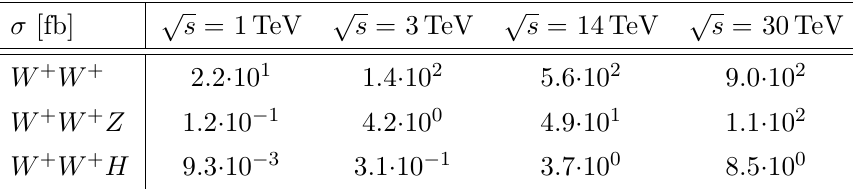
Table 5 . SM cross sections [fb] for sample W + W + fusion processes in (cid:22) + (cid:22) + collisions at repre- sentative collider energies